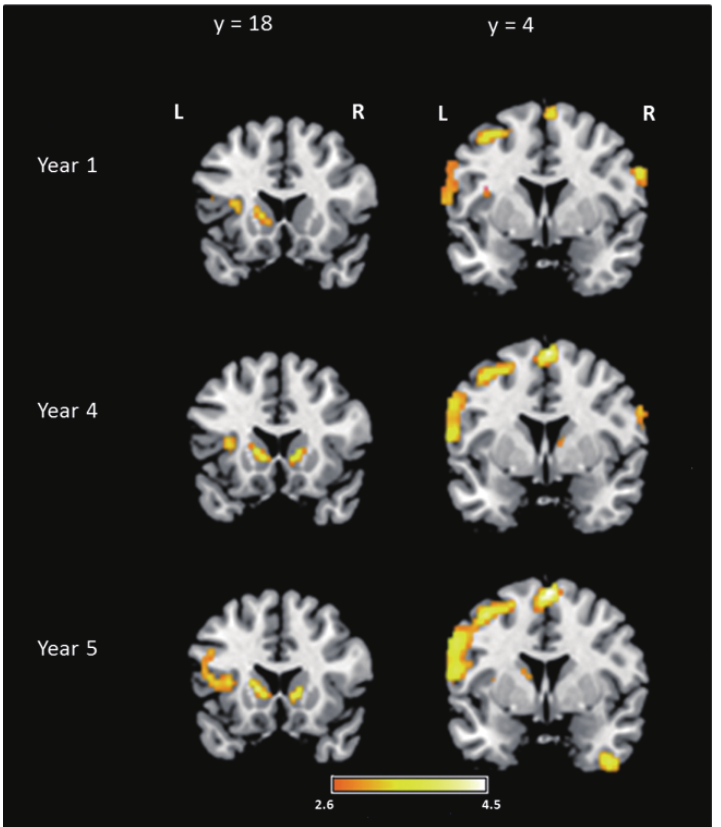
Fig. 2. VBM results of FC’s scans performed in Year 1, Year 4 and Year 5 compared to controls. The patient underwent 5 scans (year 1-year 2- year 3- year 4- year 5). Since the same pattern of atrophy has been shown at year 1, 2 and 3, we present only year 1 MRI scan. Areas of atrophy indicated in yellow (see the color bar) are superimposed on coronal sections ( y = 18; y = 4) of the mean image of all subjects used to create the template used for normalization. Include image statistical thresholding information. R: right; L: